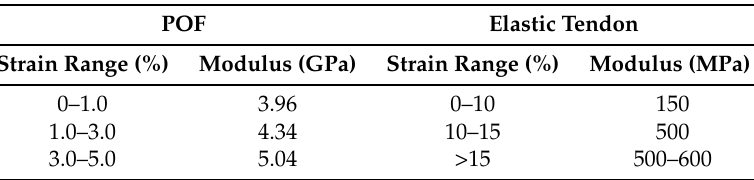
Table 1. Stress–strain modulus for specific strain ranges of Polymer Optical Fiber (POF) and the elastic tendon.